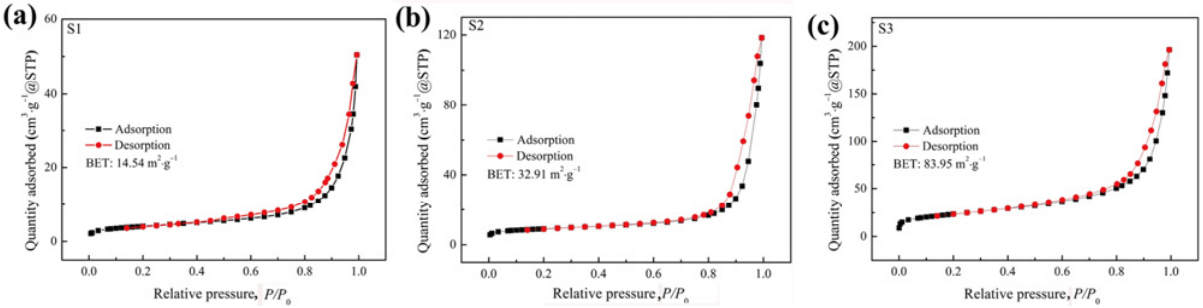
Fig. 4 N 2 adsorption and desorption isotherms of S1, S2, and